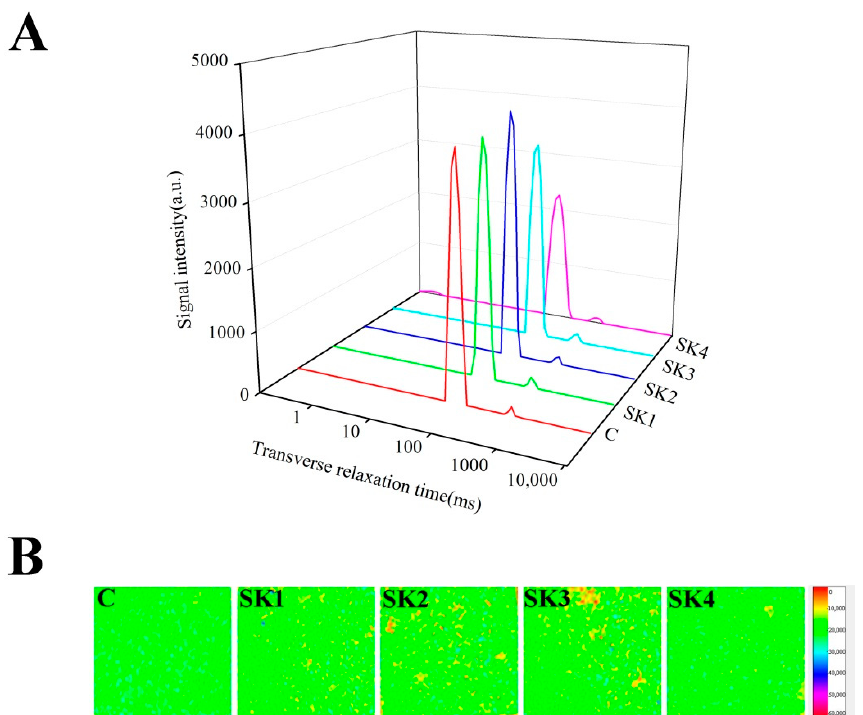
Figure 4. LF-NMR T 2 relaxation ( A ) and MRI ( B ) of surimi gels with KEH. MRI is a nondestructive method for monitoring water molecule distribution during food processing [52]. MRI images were used to visualize the food’s internal structure. A color bar in pseudo-color mapping was used to scale the density of protons; red color meant higher densities, while purple represents lower densities [49]. The pseudo-color mapping of the control sample was green and uniform, which indicated immobile water in surimi gels. The yellow and red spots in the image of surimi gels with KEH were observed, which meant that there was free water in surimi gels corresponding with the result of other dietary fibers in surimi gels [5,29]. With the M w decrease in KEH, the SK2 sample exhibited the most yellow and red spots. Moreover, the number of yellow spots decreased with the further decline of M w of KEH and the pseudo-color mapping of SK4 became even.